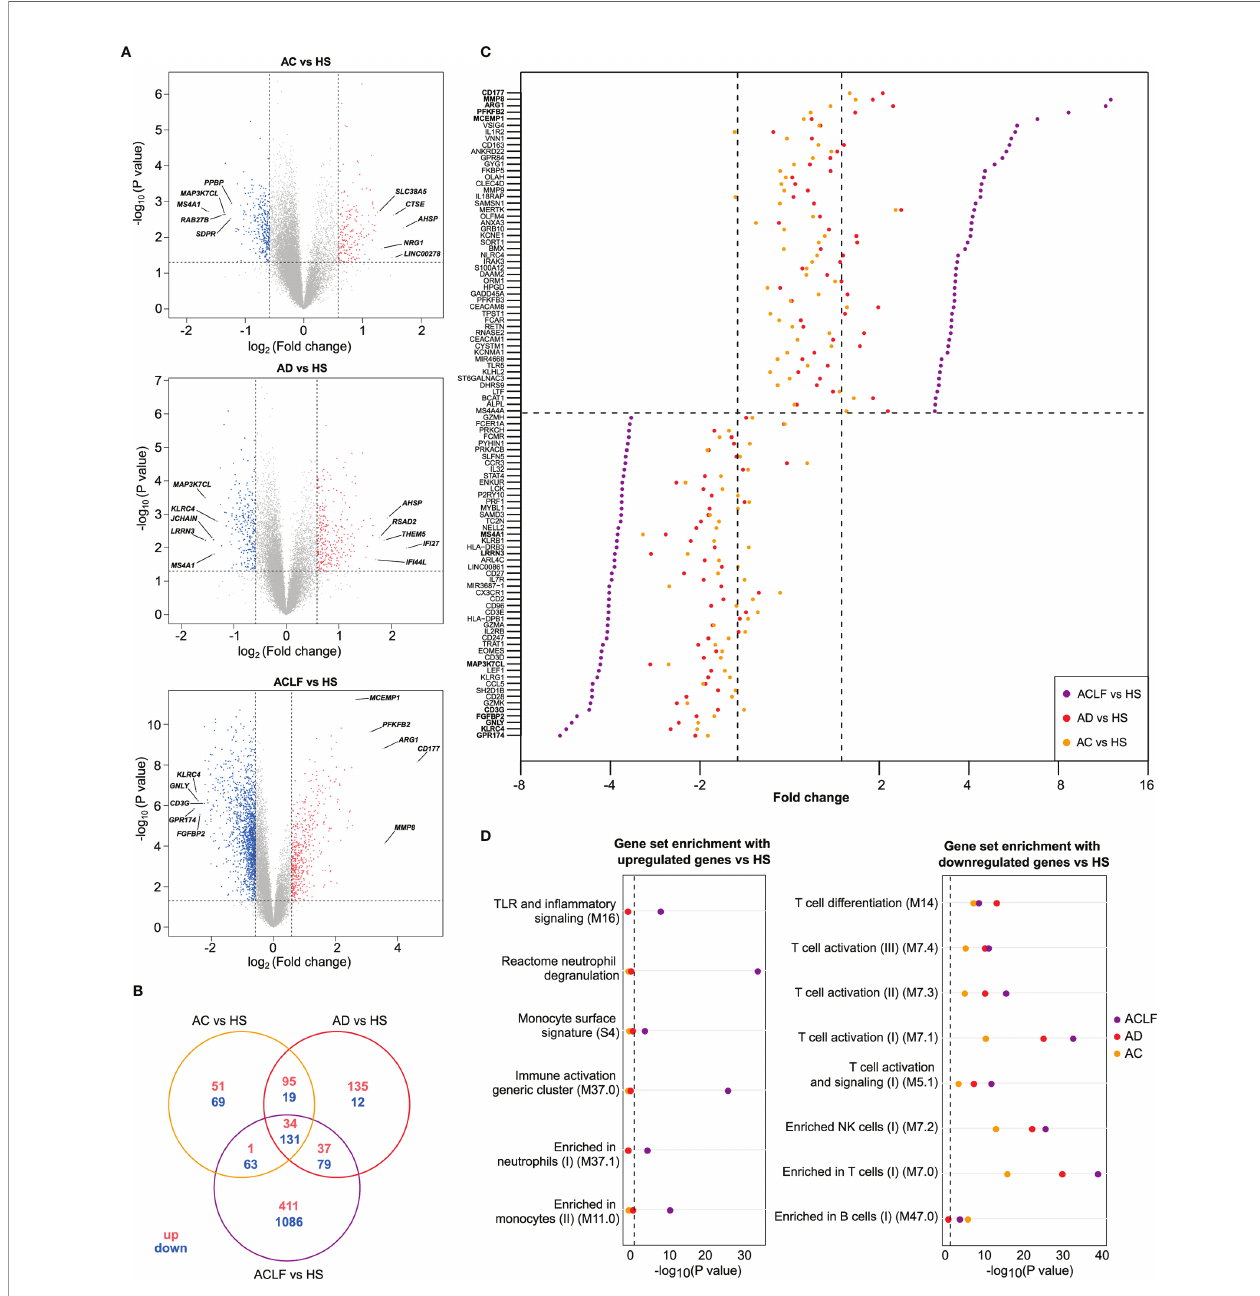
FIGURE 2 | Distinctive transcriptional characteristics of ACLF. (A) Volcano plots of differential gene expression between each patients ’ group [AC (n=7); AD (n=7); ACLF (n=17)] relative to healthy subjects [HS (n=7)], with signi fi cance ( − log 10 P value) plotted against the log 2 fold-change (patients:HS ratio). Genes were considered as differentially expressed when P was <0.05 (or − log 10 P >1.3; dashed horizontal line) and fold-change >1.5 [or log 2 fold-change >0.58 for upregulation or log 2 fold- change <-0.58 for downregulation (right and left dashed vertical lines, respectively)]. Gray points indicate genes with no signi fi cant difference in expression, salmon indicates genes with signi fi cantly increased expression in patients and blue indicates genes with signi fi cantly decreased expression in patients. Representative differentially expressed genes are shown. CD177 was the most upregulated gene in ACLF versus HS. Between-group comparisons were performed using Student ’ s t -test. (B) Venn diagram showing the number of up- and downregulated genes that were unique or not to each of the three pairwise comparisons. (C) Cleveland plot showing the fold-changes for the 50 most upregulated genes in ACLF versus HS (top) and in the 50 most downregulated in this comparison (bottom). The dashed horizontal line separates upregulated genes from down regulated genes. For each gene, the fold-change of expression is also shown for two other pairwise comparisons: AD versus HS and AC versus HS. A dashed vertical line (right) indicates the threshold of 1.5 fold-change versus HS and the other dashed vertical line (left) indicates the threshold of -1.5 fold-change versus HS. (D) Results of enrichment analysis of prede fi ned data sets (which, unless speci fi ed, were blood transcription modules (21)) with upregulated genes (left) and downregulated genes (right), both in ACLF versus HS. The enrichment of these gene sets with genes that were upregulated (left) or downregulated (right), in AC versus HS and AD versus HS genes, are also